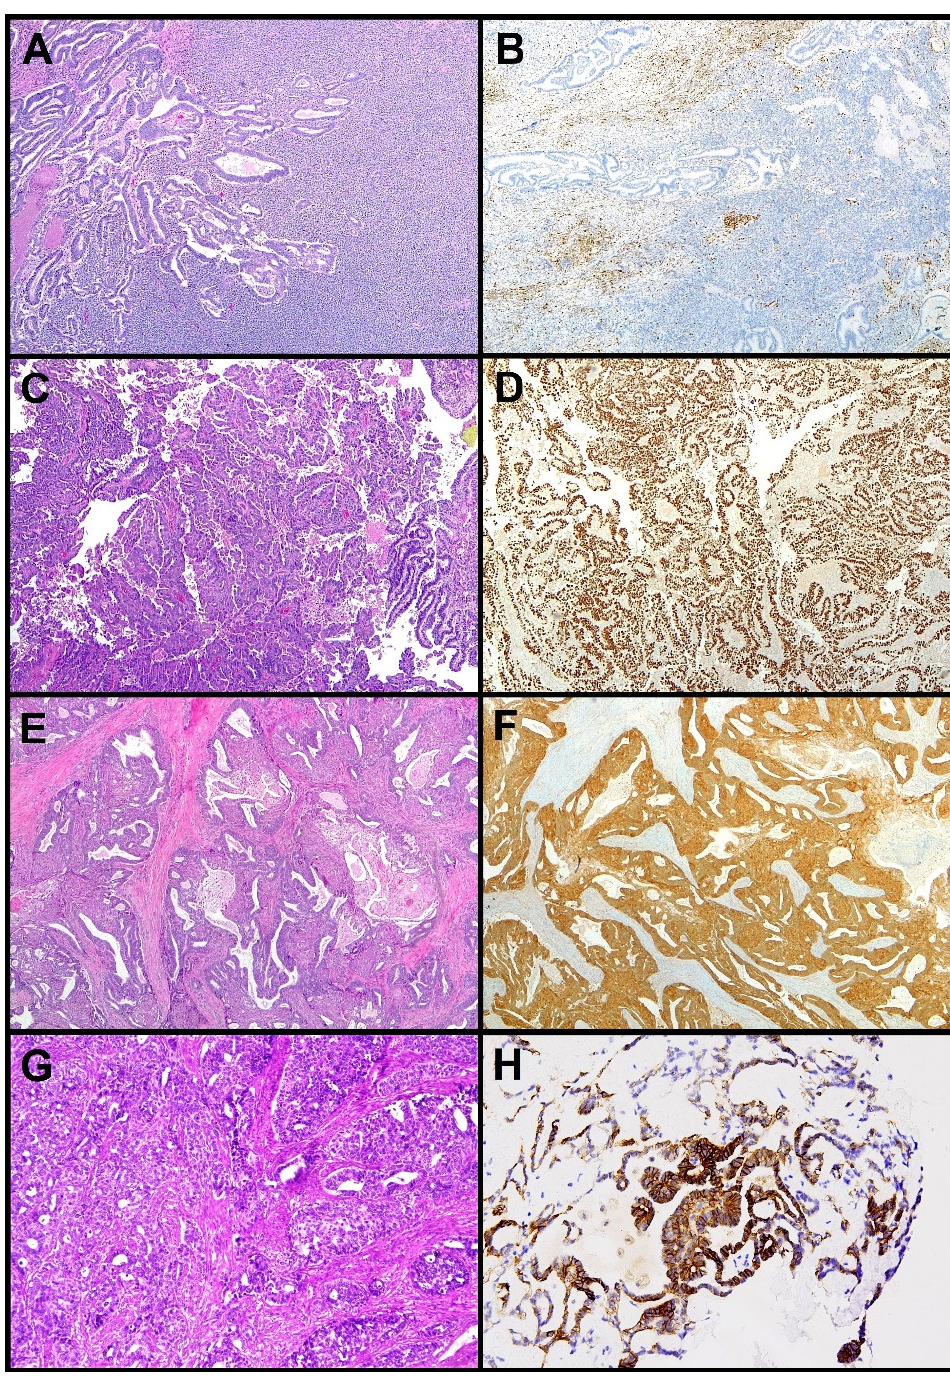
Figure 2. Molecular landscape of endometrial carcinoma: the role of the immunohistochemical surrogates. ( A , B ) Dedifferentiated carcinoma with mismatch repair deficiency. ( C , D ) Serous carcinoma with abnormal p53 expression. ( E , F ) Endometrioid carcinoma with nuclear beta-catenin accumulation. ( G , H ) Endometrioid carcinoma with positivity for L1CAM in >10% of tumor cells (H&E, LSAB, 10×).